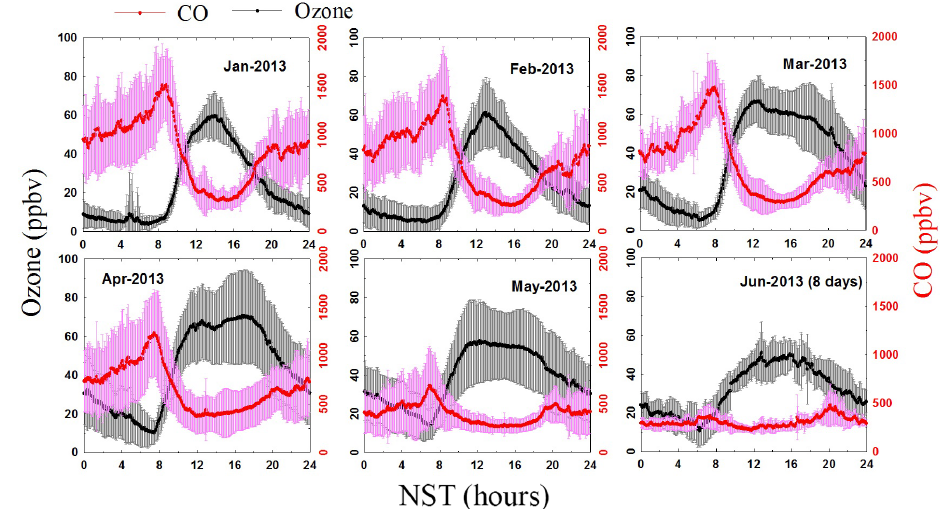
Figure 5. Monthly variations in average diurnal O 3 and CO mixing ratios with 1 σ spread at Bode during January–June